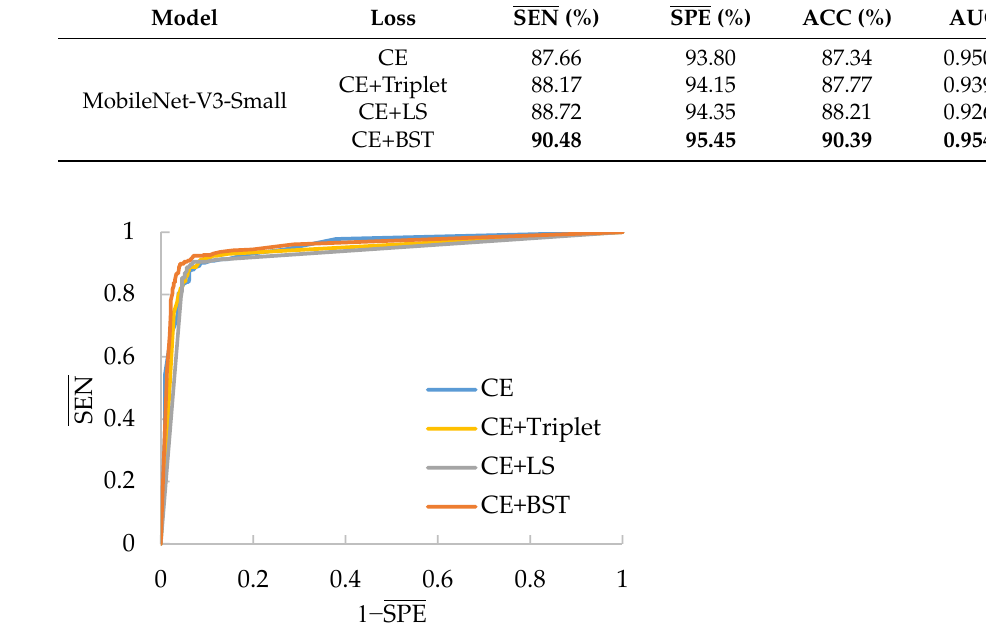
Figure 14. Examples of the osteosarcoma histology images. ( a ) Non-tumor; ( b , c ) necrotic tumor; ( d , e ) viable tumor. Table 9. The construction of the osteosarcoma histology image dataset.